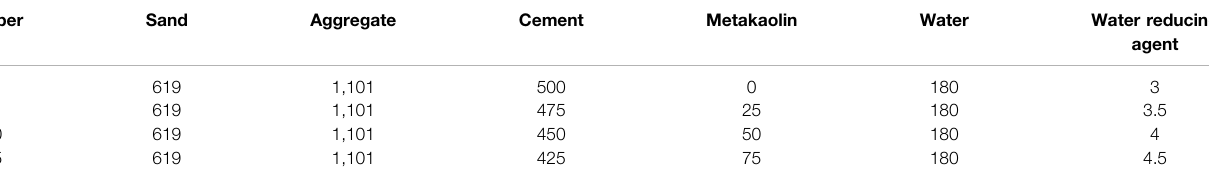
TABLE 2 | Mix proportion of concrete (kg/m³).